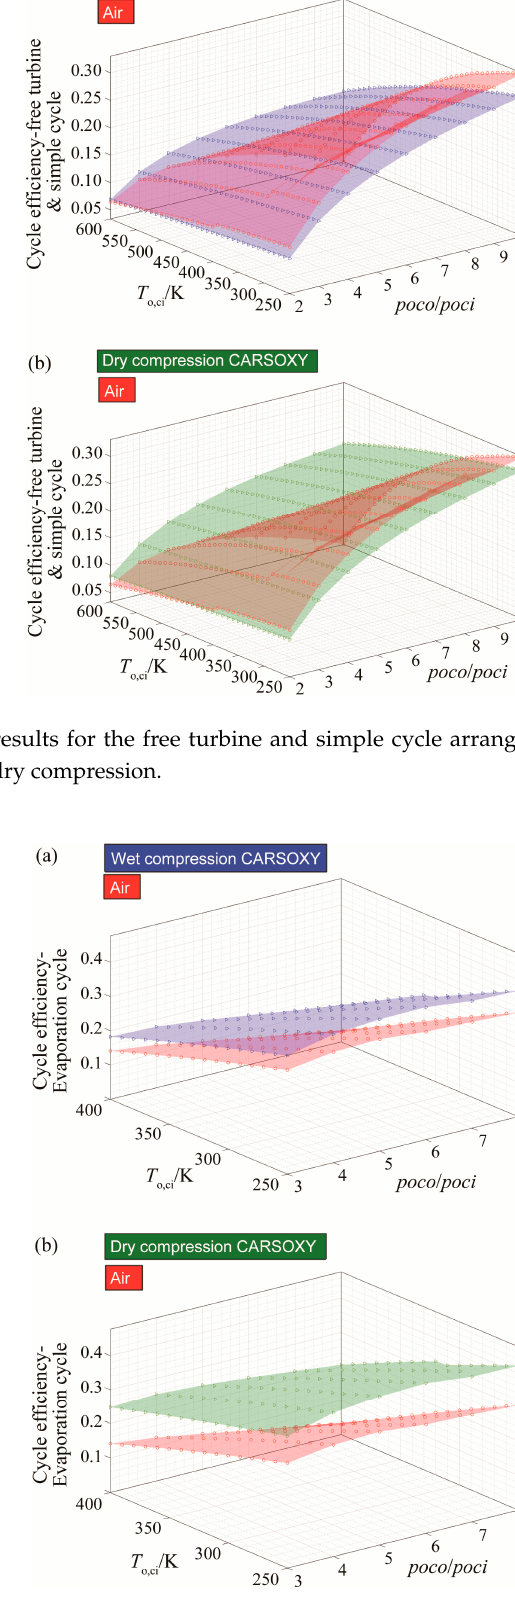
Figure 6. Efficiency results for the humidified gas turbine cycle using ( a ) wet compression and ( b ) dry compression.